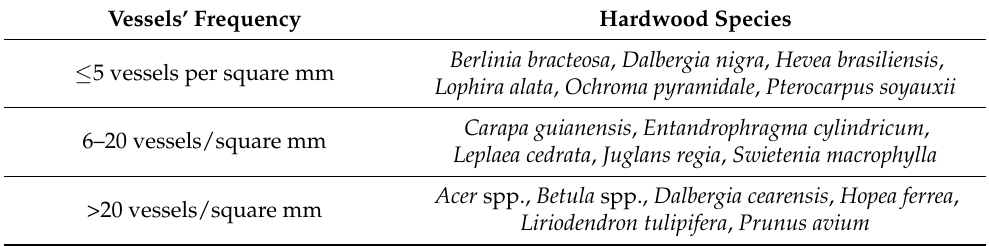
Table 14. Examples of species for different vessel frequencies.